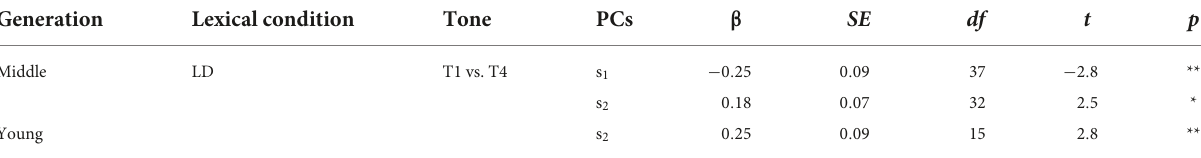
TABLE 4 Summary of linear mixed-effects modeling for F0 velocity profiles (from subset data of generation, tone, and homophone neighborhood